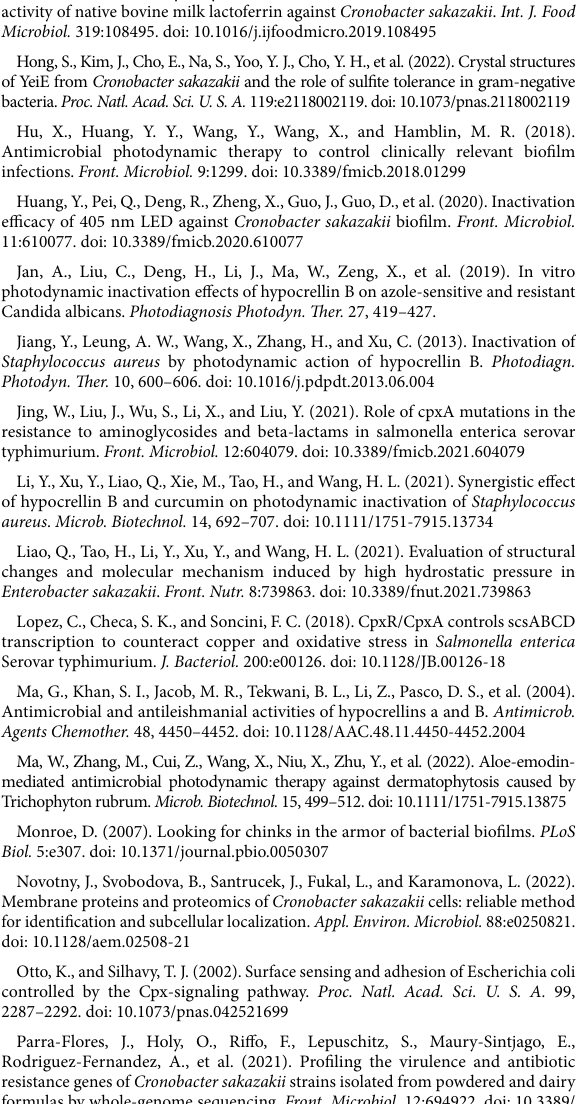
SUPPLEMENTARY FIGURE S1 The growth curve of Cronobacter sakazakii ATCC29544 and Δ CpxA. Values are the mean ± SEM (standard error of mean) from 3 replicates.